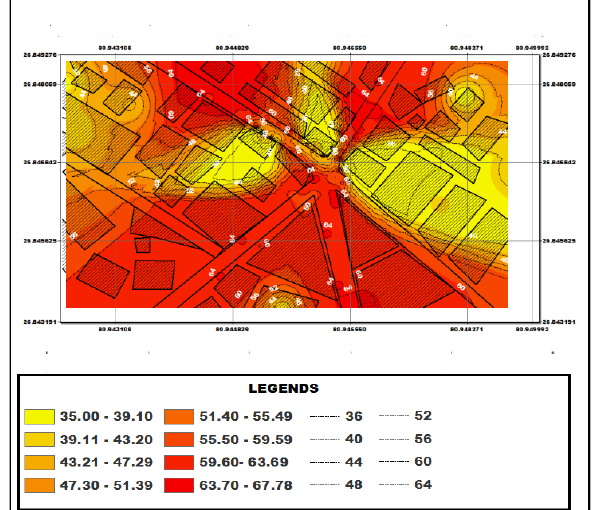
Figure 4. Noise level map of Hazartganj Intersection at afternoon time using NoiseCapture app scaled with standard SPL.